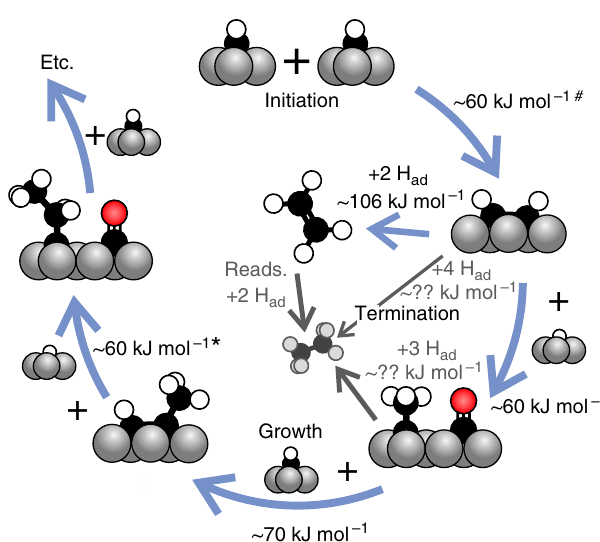
Fig. 8 Proposed chain growth mechanism on close-packed terraces. Steps depicted in colour were either observed directly or derived from direct observation of analogue reactions. The barrier for CH + CCH 2 R is proposed to be between the 60 kJ mol − 1 reported for CH dimerization 4,31,43,44# and 75 kJ mol − 1 for ethylidyne dimerization. Chain termination via hydrogenation can occur at any point but is only shown explicitly for C 2 H x . Experimental proof for CO-induced propylidyne and 1-butylidyne formation can be found in ref. 32